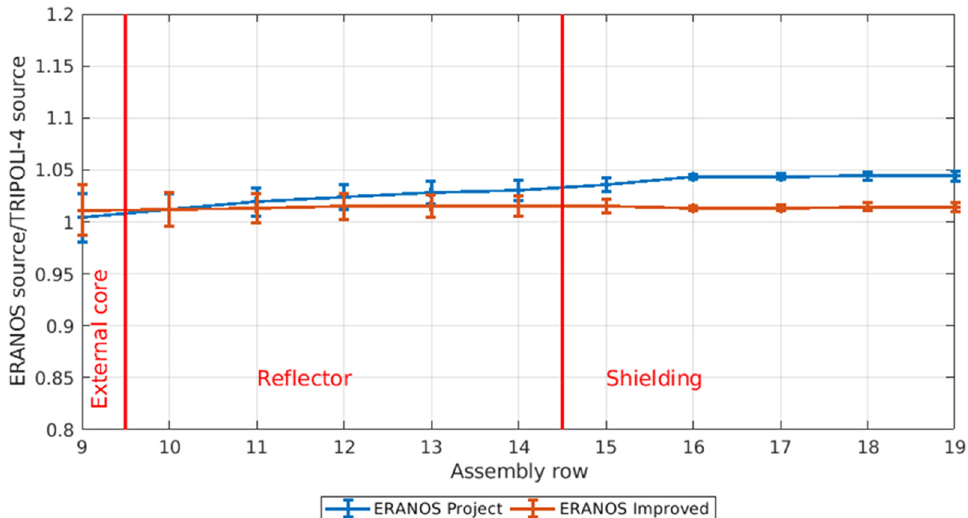
Fig. 9. Shielding calculations with variance reduction techniques: radial fl ux traverse comparison between the deterministic sources and stochastic source.